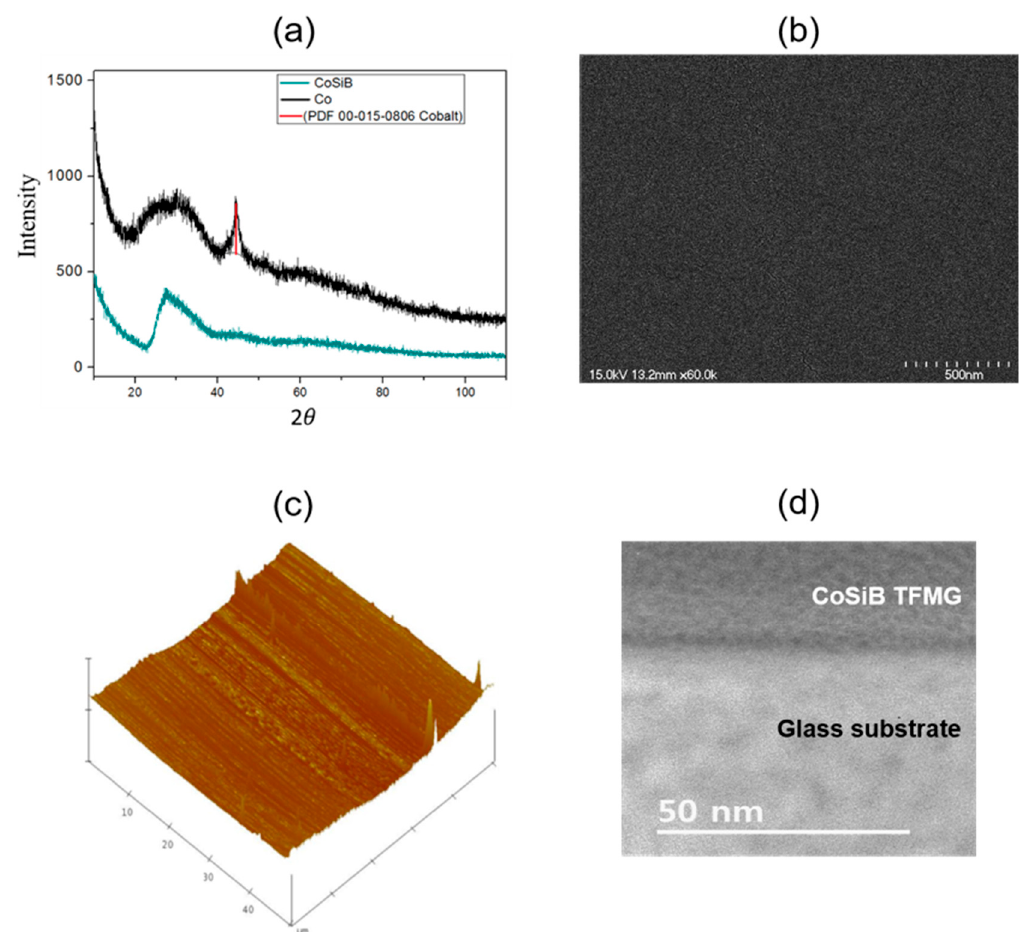
Figure 3. Structural and morphology characterization CoSiB TFMG: ( a ) the X-ray pattern of the CoSiB TFMG and Co film (100 nm thick TFMG). ( b ) An SEM image of the surface of the CoSiB TFMG captured using a field-emission SEM (100 nm-thick TFMG). ( c ) Morphology scanning and thickness measurements by AFM (100 nm thick TFMG). ( d ) A TEM image of the cross-section across the film–substrate boundary of the 200 nm thick TFMG.